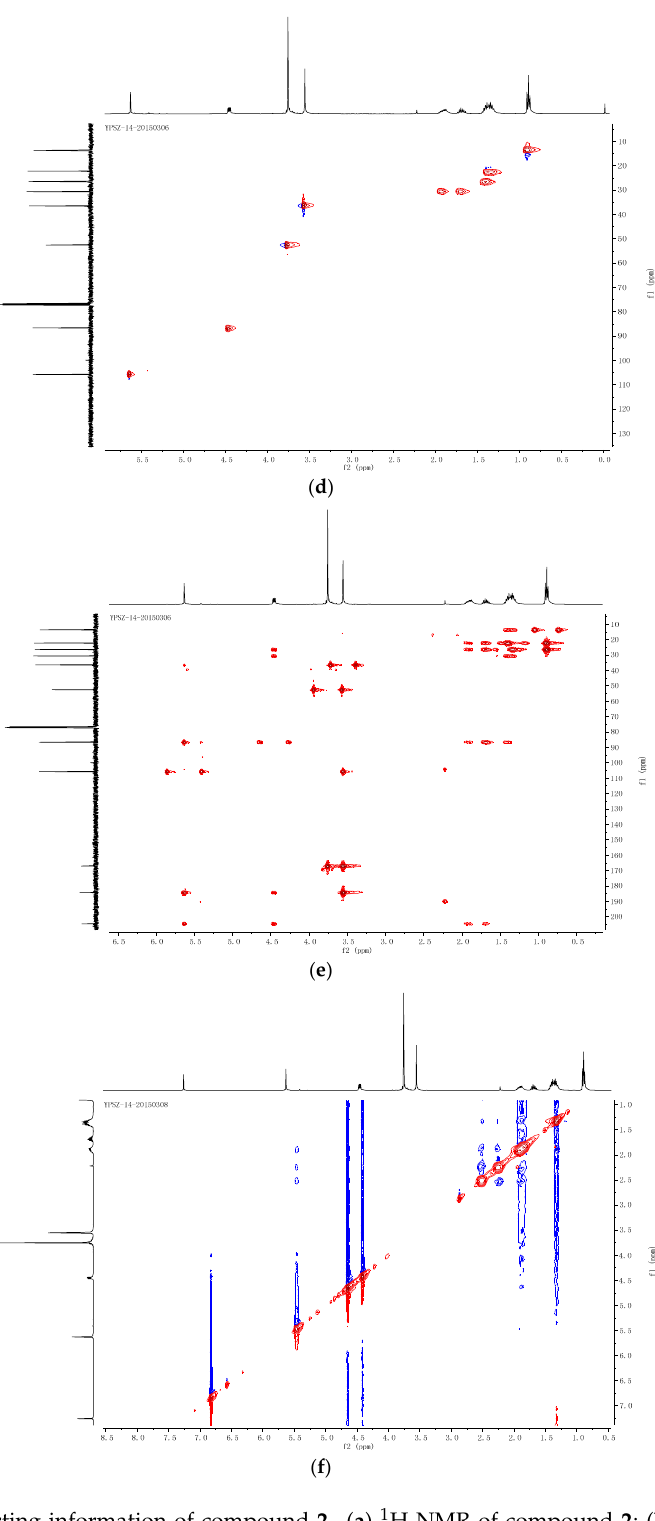
Figure 5. Supporting information of compound 2 . ( a ) 1 H-NMR of compound 2 ; ( b ) 13 C-NMR and DEPT of compound 2 ; ( c ) HSQC of compound 2 ; ( d ) 1 H- 1 H COSY of compound 2 ; ( e ) HMBC of compound 2 ; ( f ) NOESY of compound 2 .